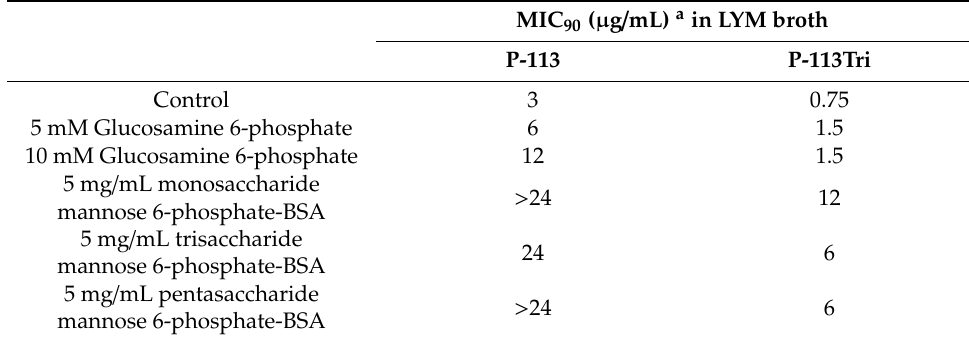
Table 3. Exogenous phosphosugars reduce the anti- C. albicans activity of the